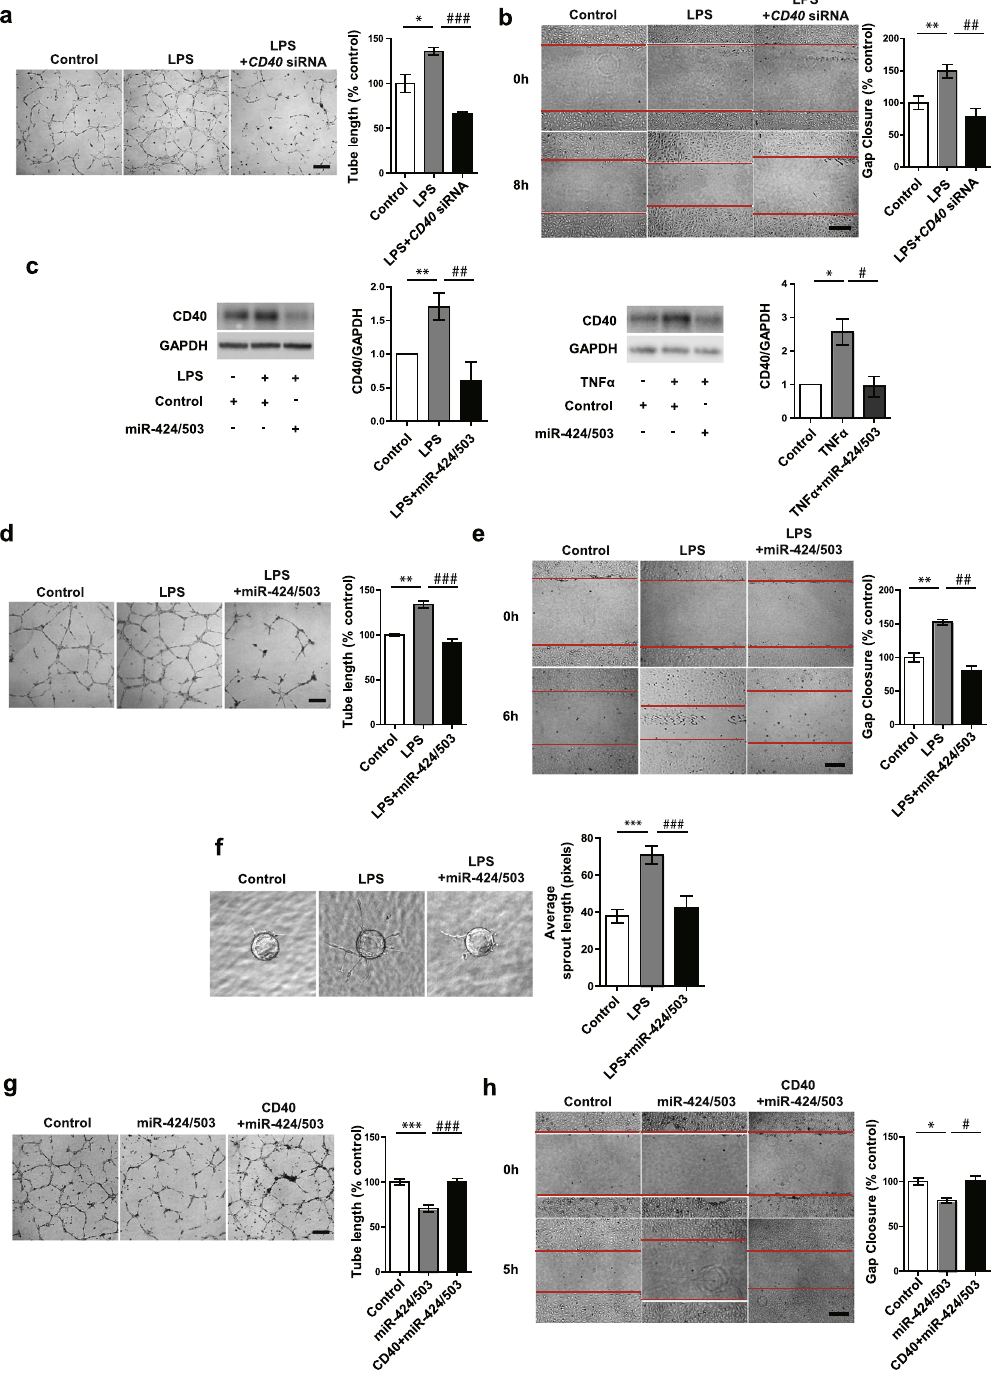
Figure 3. Inhibition of CD40 abrogates LPS-induced endothelial angiogenic response. ( a , b ) Tube formation and cell migration assay response to LPS (1 μ g/ml) with or without CD40 knockdown. Tubes were assessed at 8 h after cell plating. ( c ) CD40 protein expression in response to LPS (1 μ g/ml), TNF α (10ng/ml) with or without miR-424 and miR-503 overexpression. ( d , e ) Tube formation and migration assay response to LPS (1 μ g/ml) with or without miR-424/503 overexpression. Tubes were assessed at 8 h after cell plating. ( f ) Sprouting assay using miR-424/503 transfected HUVEC coated beads with or without LPS (1ug/ml) treatment. ( g , h ) Tube formation and migration assay response to miR-424/503 overexpression with or without CD40 overexpression at 5 h. * P < 0.05, ** P < 0.01, *** P < 0.001 compared to controls. # P < 0.05, ## P < 0.01, ### P < 0.001 compared to LPS or miR-424/503. Scale bar, 200 μ m. Error bars, s.e.m. Images are representative of three independent experiments. Cropped gel images are shown; uncut gels are included in the Supplementary